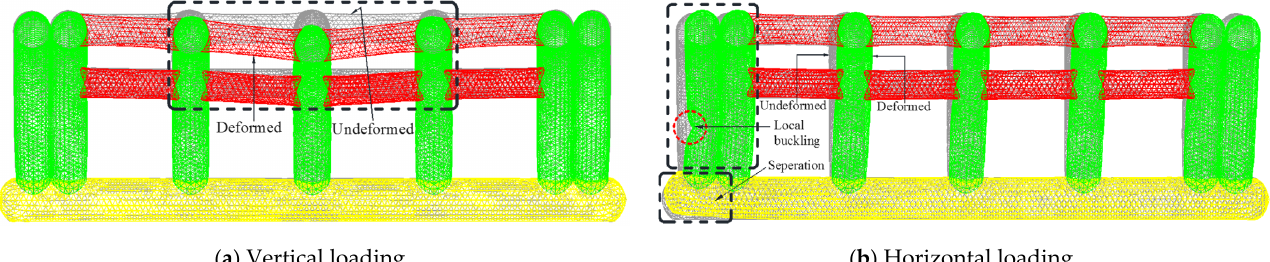
Figure 6. Undeformed and deformed shape of inflatable arch frame [4].